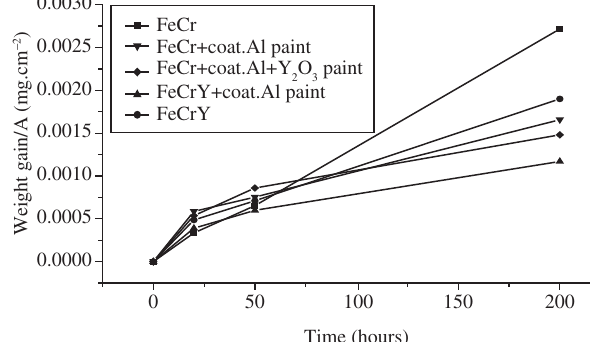
Figure 4. Oxidation mass change curves of the uncoated and the different paint coated alloy specimens as a function of time.